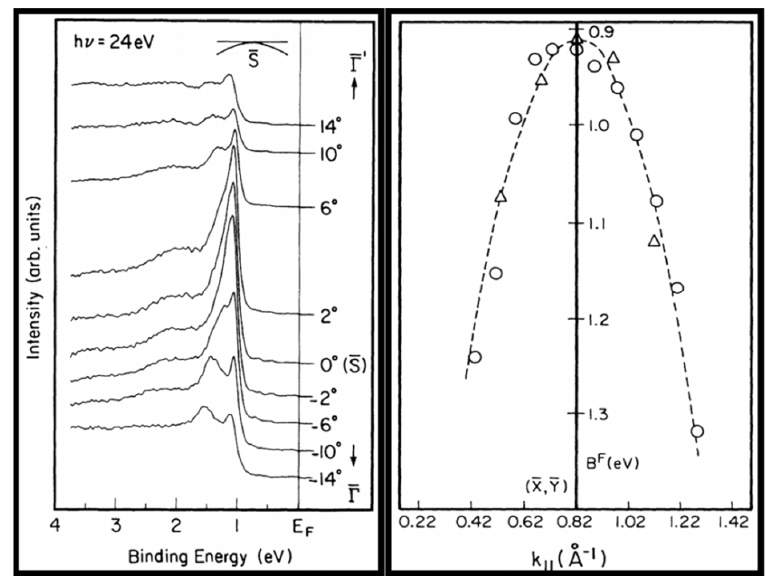
Figure 5. Dispersion of the “1 eV” state in single crystalline, twinned and untwinned YBa 2 Cu 3 O 6.9 [23]. Left panel: Spectra shown here were collected near the S-bar point of the Brillouin zone, using hv = 24 eV photons and a twinned crystal. At 14 degrees, the momentum is about halfway from S-bar to Γ -bar. Note the coalescence of the two peaks into a single peak at S-bar. Right panel: The dispersion curves for the 1-eV state near X,Y-bar are shown here. For hv = 24 eV, an untwinned crystal and near X-bar only: open circle. For hv = 74 eV, a twinned crystal, and near X-bar and Y-bar: open triangles.